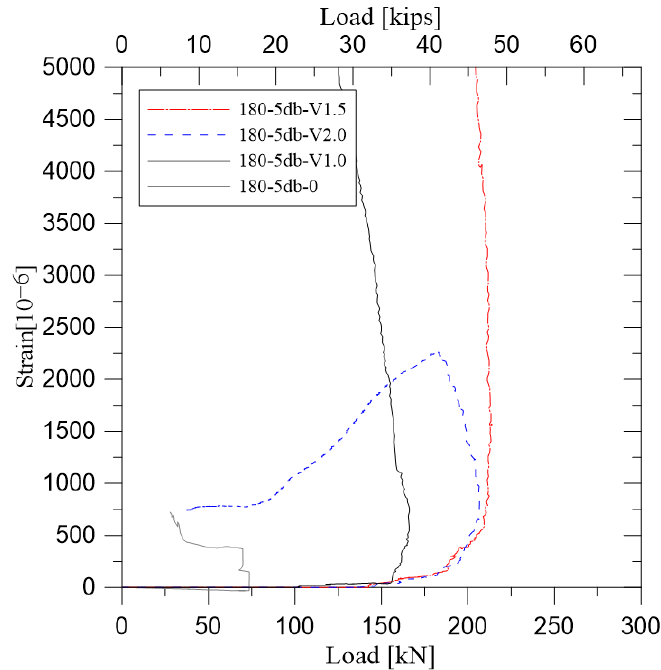
Figure 12. Expansion of concrete adjacent to the tensile lap-spliced reinforcements.